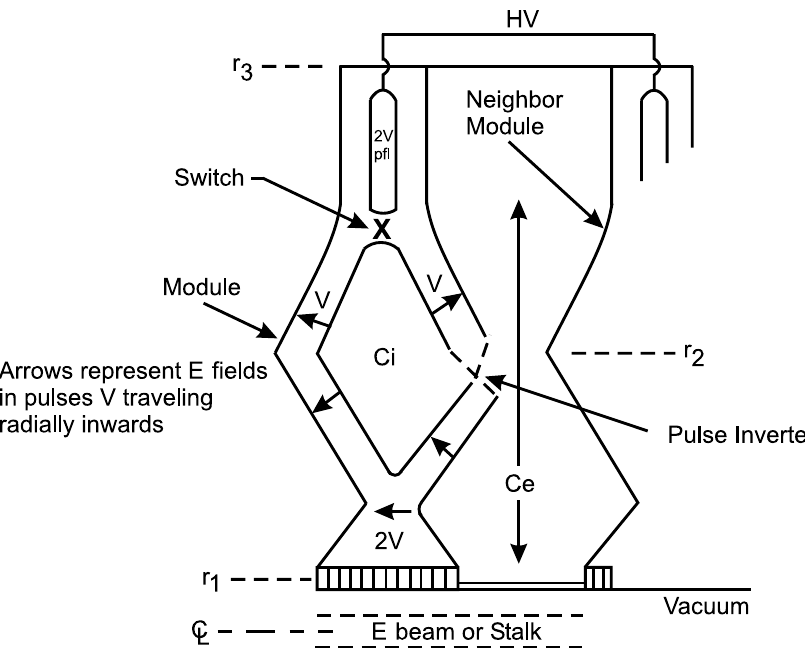
FIG. 4. Module of the air-core LIA Radlac or IVA Radlac